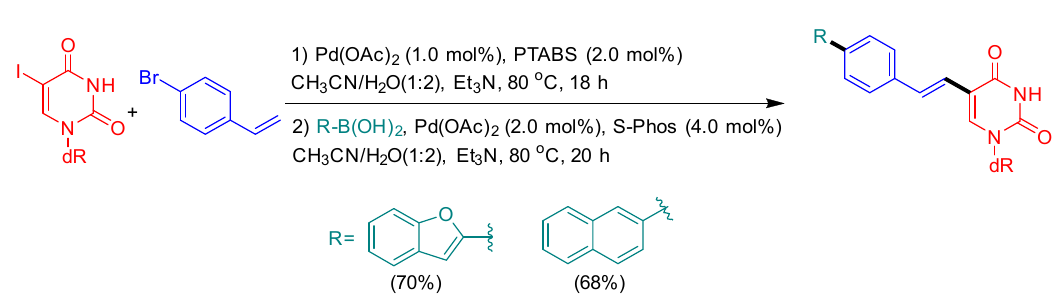
Scheme 11. Tandem one-pot Heck/Suzuki coupling of 5-IdU.